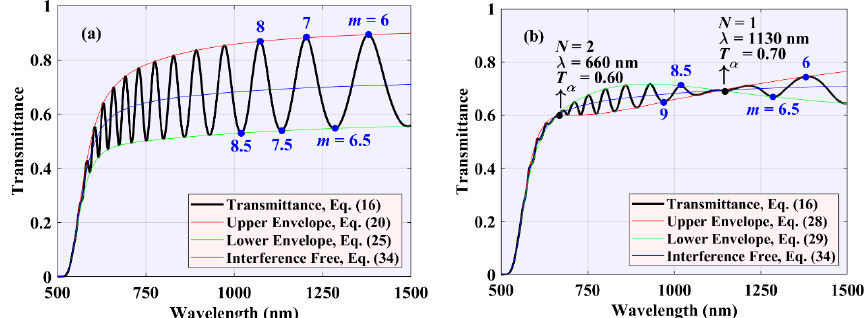
Figure 4. Simulated transmission spectrum and its upper and lower envelopes, for a postulated a -Si:H film of average of thickness d = 1500 nm, and ( a ) Δ d = 30 nm and ( b ) Δ d = 100 nm (see the text for more details).